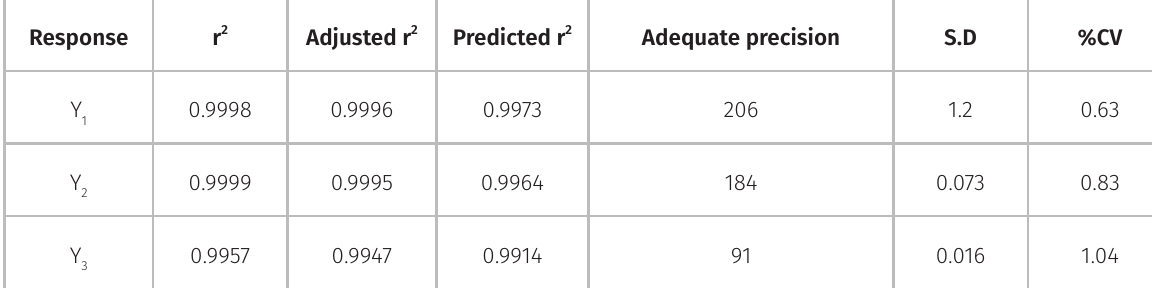
, Y , and Y for fitting to quadratic model. 1 2 3